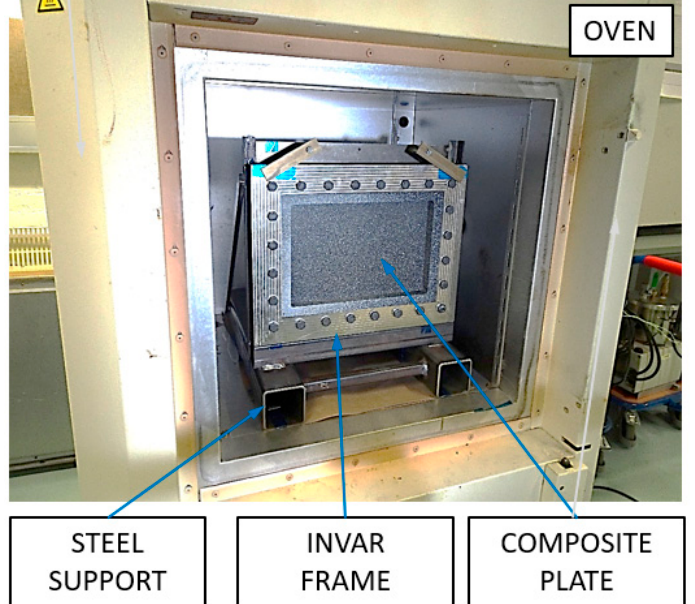
Figure 9. Specimen inside oven.